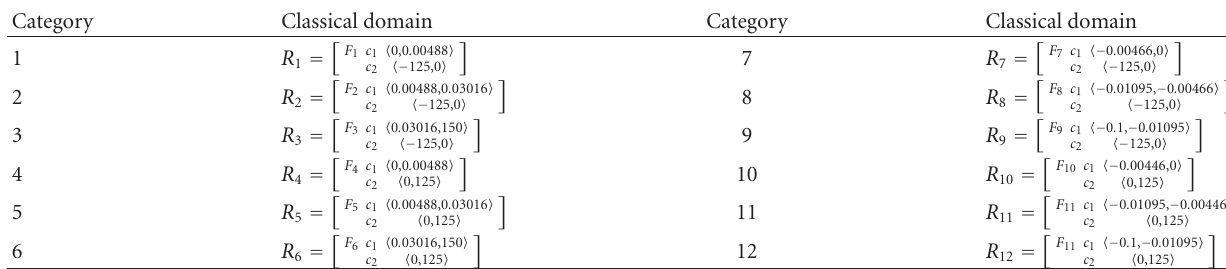
Table 2: The classical domains of